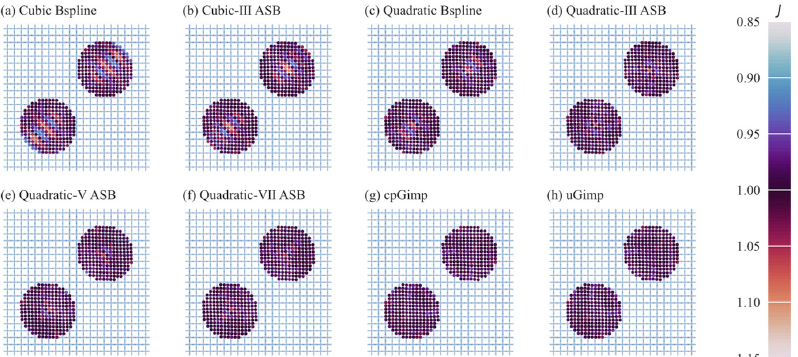
Figure 14. Departure comparison of 2D disks’ collision problem under different MPM shape functions: ( a ) cubic B-spline, ( b ) cubic-III ASB, ( c ) quadratic B-spline, ( d ) quadratic-III ASB, ( e ) quadratic-V ASB, ( f ) quadratic-VII ASB, ( g ) cpGIMP, ( h ) uGIMP. The moment t = 3.0 s is chosen. Each particle is colored according to the volume ratio 𝐽 to reflect deformation distribution.